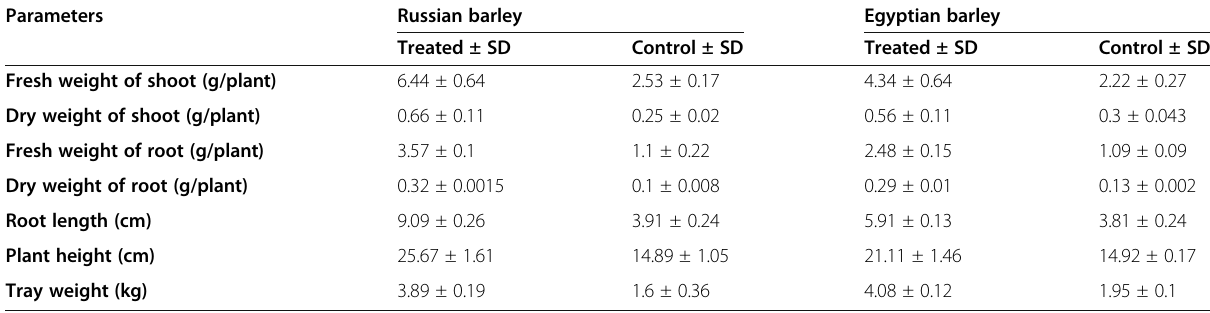
Table 1 Valuable effects of endophytic T. harzianum on physiological parameters of the barley plant that sprouted through the hydroponic system